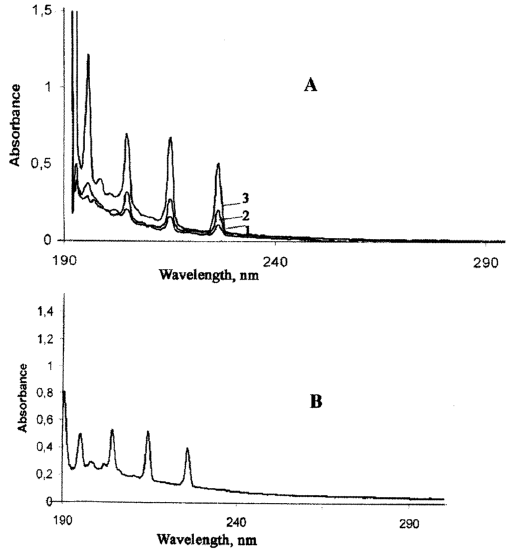
Figure 14. ( A ) the optical absorption of gaseous NO released from the solution of B-DNIC-GSH (12 mM, 17 mL, pH 1.0) heated at 80 °C for 3, 10 or 60 min (curves 1–3, respectively). ( B ) the absorption spectrum of a standard sample of gaseous NO (200 µ mol in 100 mL of the free volume of the Thunberg apparatus) [40]. (With permission).